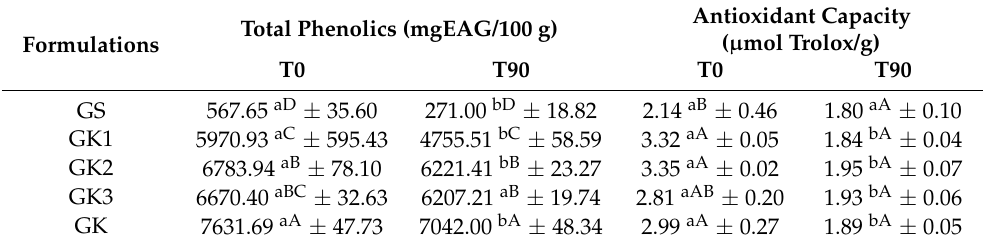
Table 4. Total phenolic compounds and antioxidant capacity of ice cream after 0 and 90 days of storage.